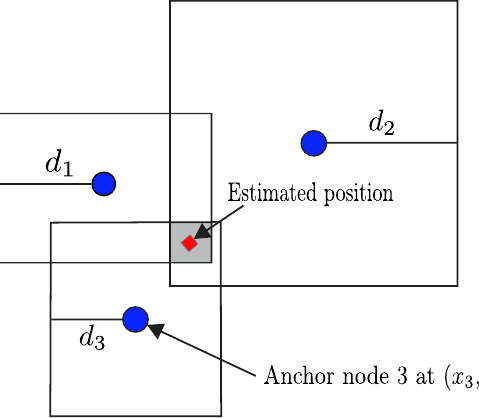
Figure 2. Min-max multilateration for the case of three anchor